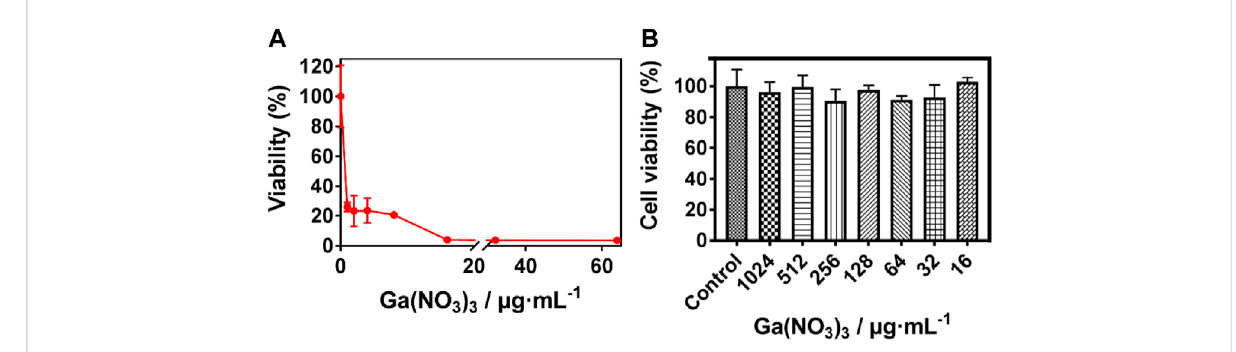
FIGURE 1 Susceptibility of P. aeruginosa to Ga (NO 3 ) 3 . (A) Minimum inhibition concentration of Ga (NO 3 ) 3 against P. aeruginosa , (B) Cytotoxicity of Ga (NO 3 ) 3 to MRC-5 (mean ± SD, n = 3).